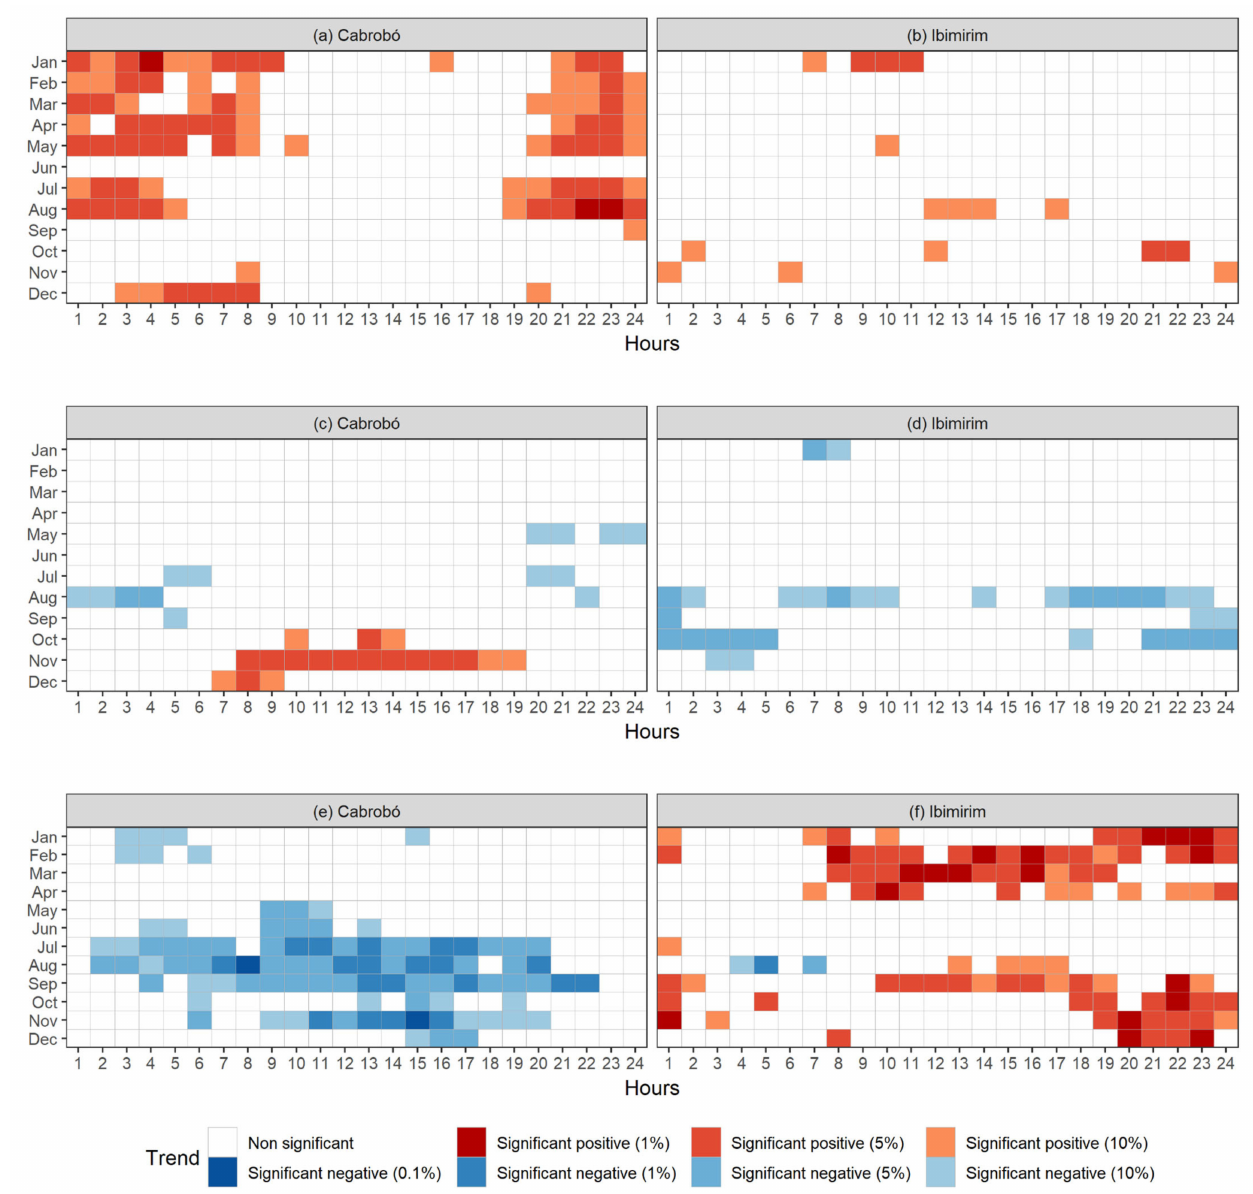
Figure 6. Hourly linear trends for air temperature ( a , b ), relative humidity ( c , d ), and wind speed ( e , f ). The first column refers to the Cabrob ó site, and the second column refers to the Ibimirim